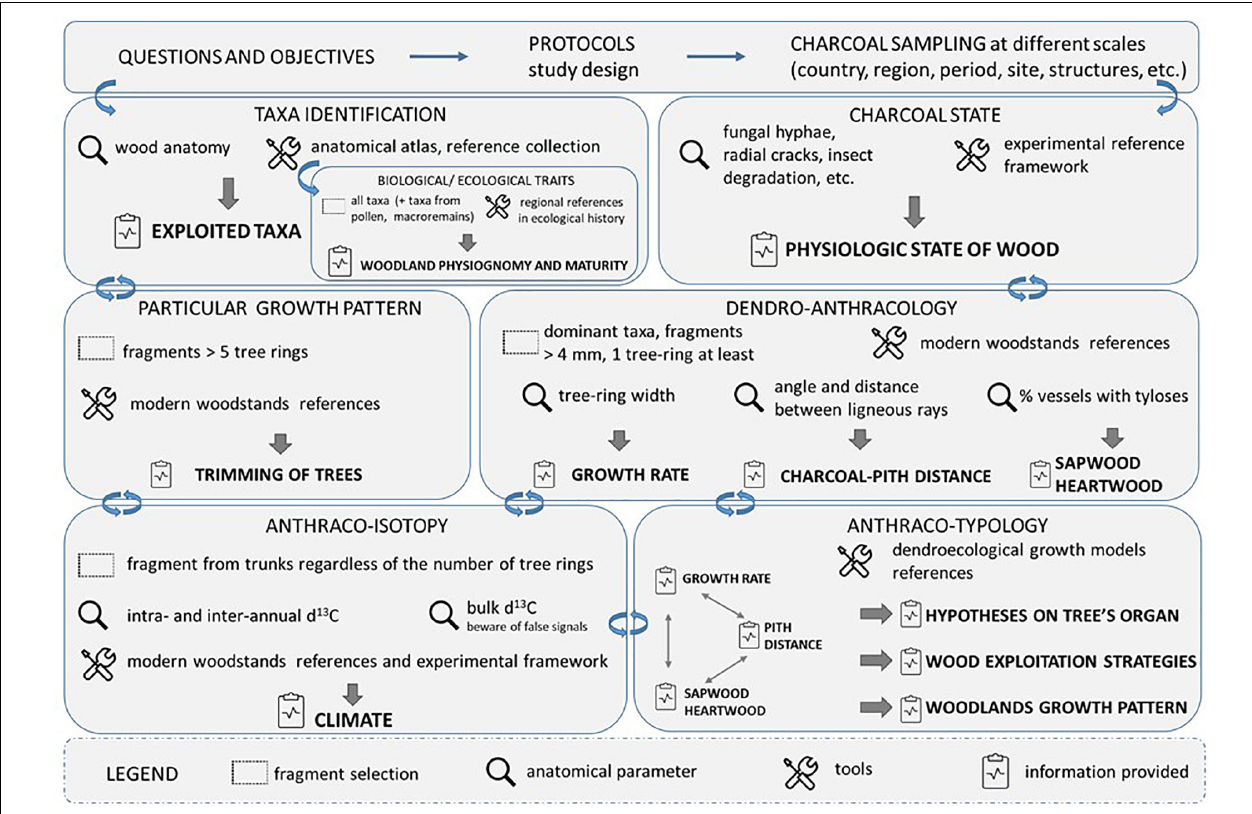
FIGURE 2 | From taxa identification to anthraco-typology and anthraco-isotopy: contribution of dendro-anthracological analysis of archeological charcoal assemblages to characterize wood exploitation practices, woodland management and